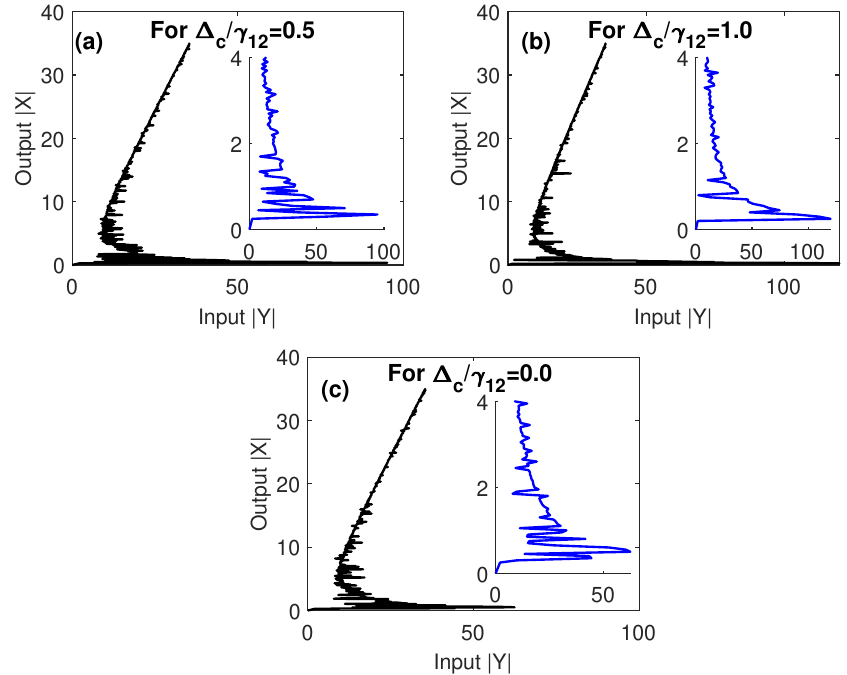
∆ c , under EIT conditions; γ 12 = 0.4 rad, θ = 1 rad and C = 121.36, M G